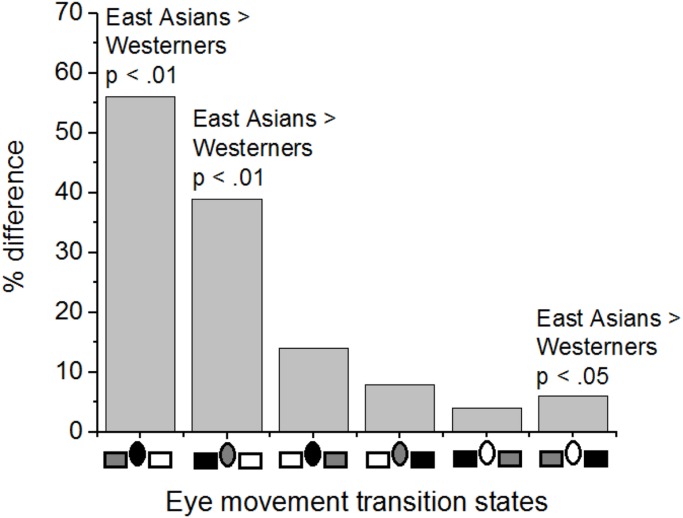
Cultural differences in eye movement transition percentages between interest areas. On the x-axis, rectangles represent left and right flanking faces, and an ellipse represents the focal face. The three interest areas are configured to depict transitions from the dark-shade area to the light-shade area. For example, in the first column, East Asians made a higher percentage of eye movements than Westerners from the focal face (i.e., dark shade) to the left flanking face area (i.e., light shade).